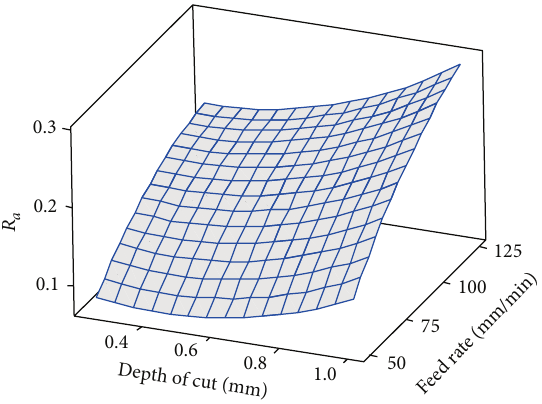
Figure 10: Surface plots for 𝑅 𝑎 versus depth of cut and table feed rate at a mean spindle speed of 875 rpm.